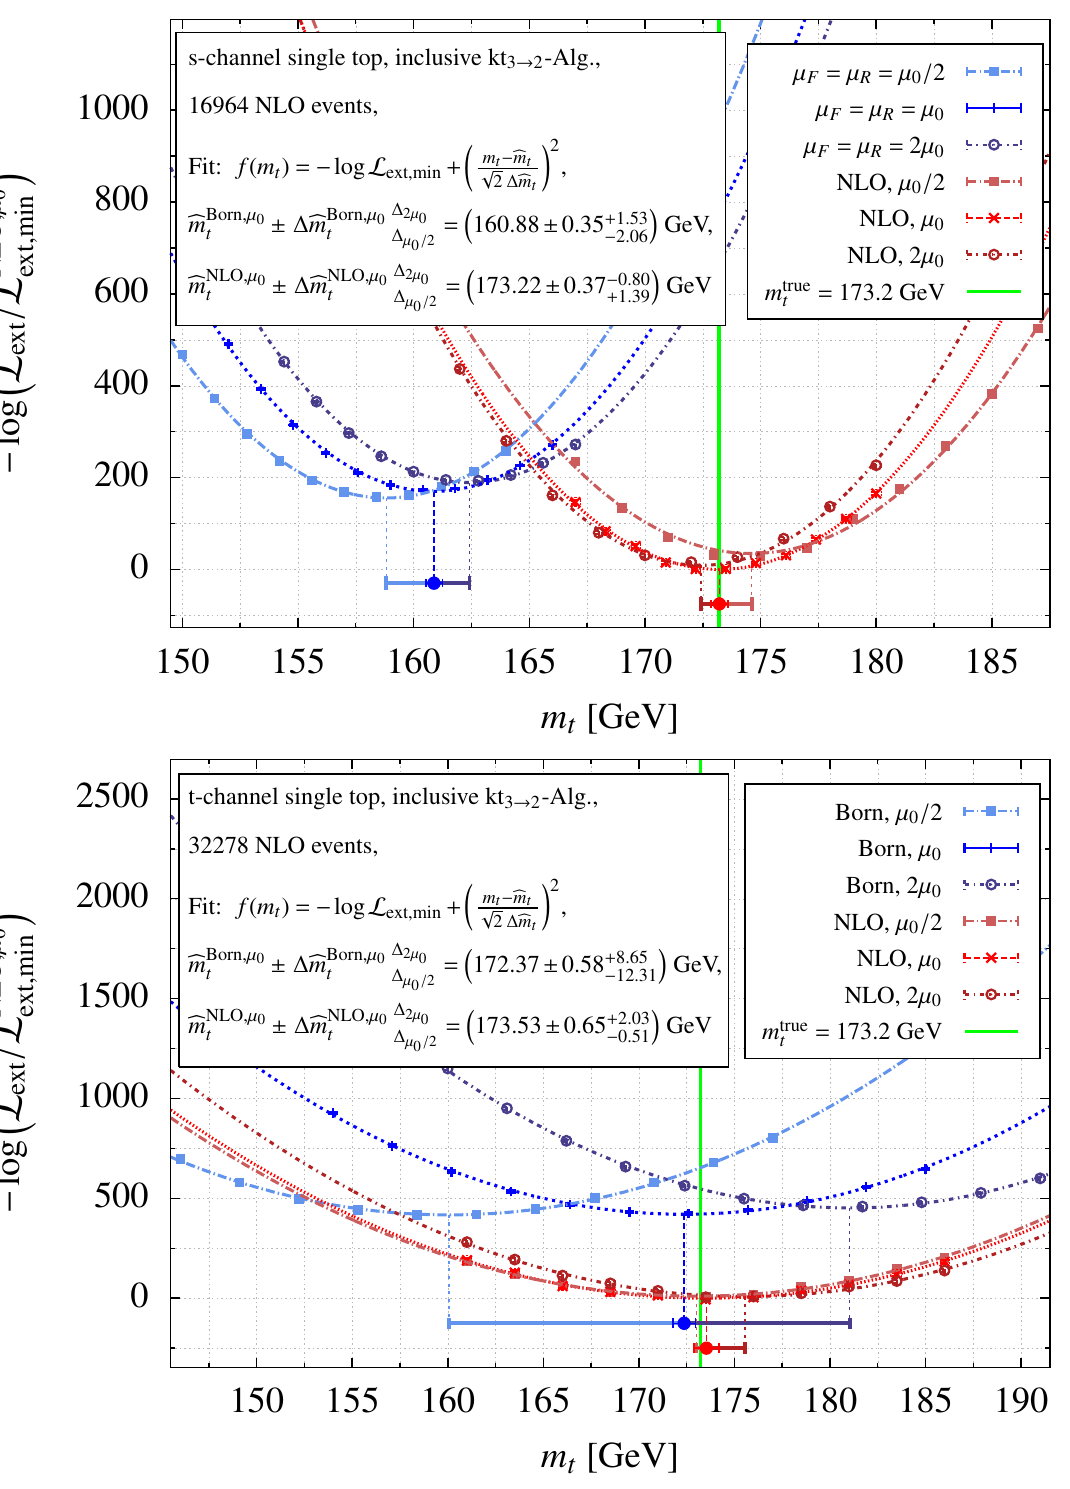
Figure 17 . Same as (cid:12)gure 15 but using the extended likelihood.